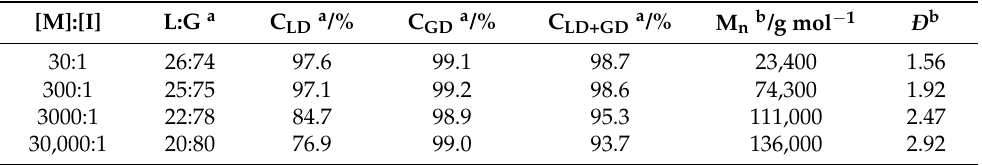
Figure 1. ( a ) SEC traces and ( b ) Mark–Houwink–Sakurada (MHS) plots for PLGA25 synthesised using various [M]:[I] ratios. SEC analysis was performed in DMSO at 80 ◦ C using a PMMA calibration. All polymers were synthesised at 150 ◦ C for 2.5 h under N 2 , using an [M]:[C] = 6500:1. Table 1. Conversion, molecular weights, and thermal properties of PLGA25 synthesised using [M]:[I] = 30:1 to 30,000:1. All polymers were synthesized using an L:G feed ratio of 25:75. C LD = lactide conversion, C GD = glycolide conversion, and C LD+GD = total monomer conversion. All polymers were synthesised at 150 ◦ C for 2.5 h under N 2 , using an [M]:[C] =